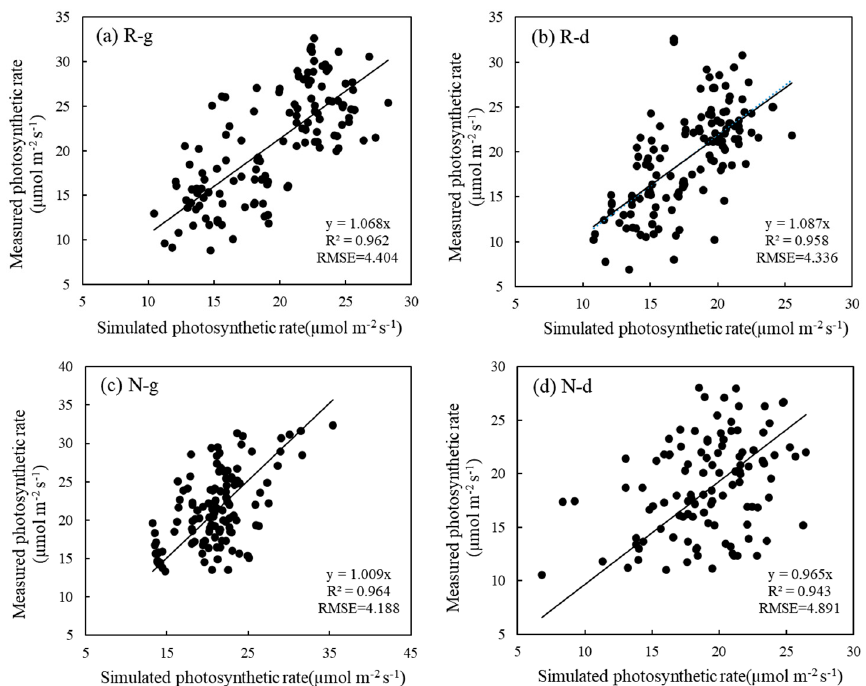
Figure 4. Fitting of measured and simulated photosynthetic rates among different treatments. ((a) R-g = warming of 1.5 °C with sufficient water supply, (b) R-d = warming of 1.5 °C with water deficit, (c) N-g = non-warming with sufficient water supply, (d) N-d = non-warming with water deficit.).